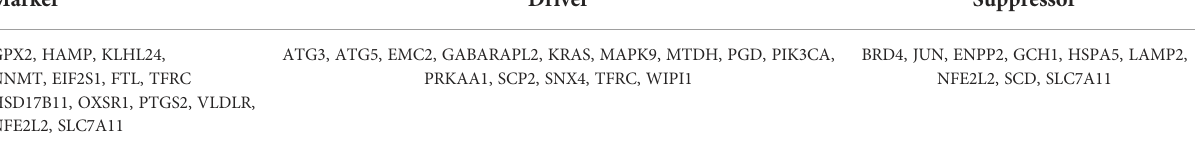
TABLE 1 The ferroptosis-related DE-mRNAs were divided into ferroptosis driver, suppressor, and marker. Marker Driver